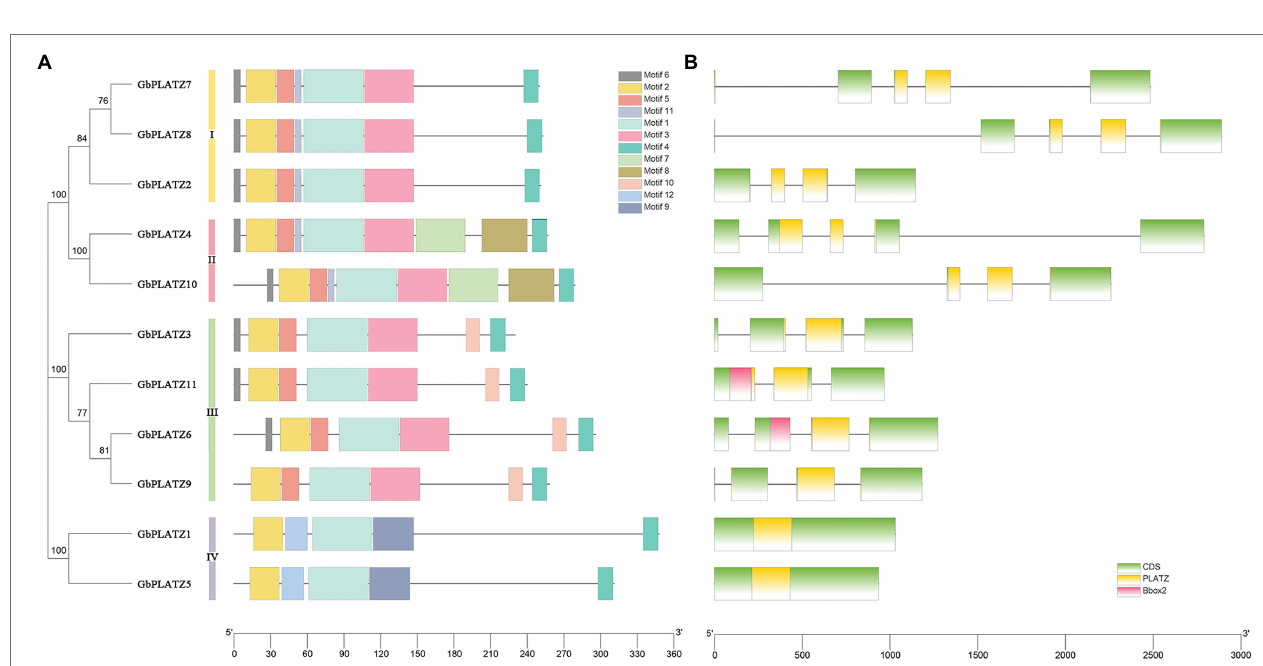
FIGURE 3 | Mapping of GbPLATZ s gene in ginkgo chromosomes. The dark gray number represents the corresponding chromosome, the length of the green bar represents the length range of the chromosome, the scale on the left represents the distance on the chromosome position, and the 11 GbPLATZ genes are represented in red. The Roman letters under the gene name represent the group.